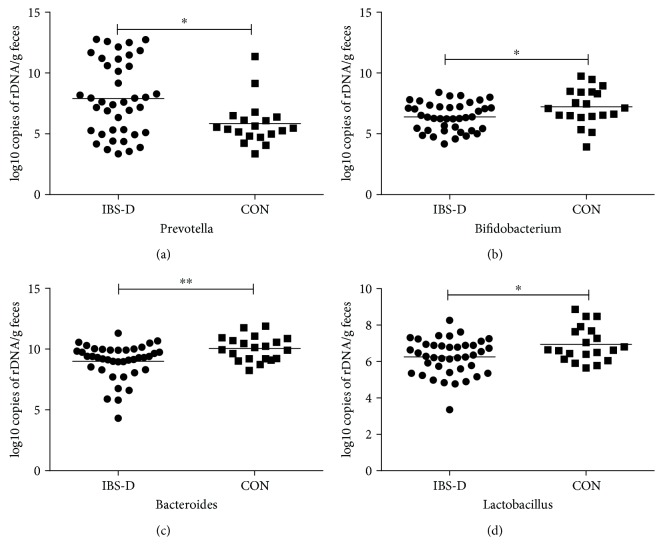
Quantity of different bacterial phylotypes in IBS-D and healthy controls (CON) measured by qPCR. IBS-D patients displayed a striking abundance of Prevotella while Bacteroides, Bifidobacterium, and Lactobacillus were significantly decreased in IBS-D compared with healthy controls. p values were calculated with the Mann–Whitney U test. ∗p < 0.05, ∗∗p < 0.01 versus the control group.